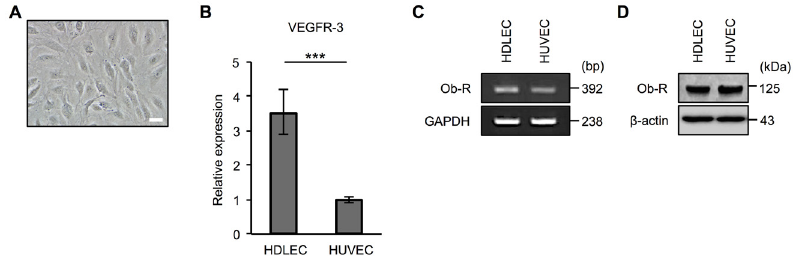
Fig 2. Characteristics of human lymphatic endothelial cells. ( A ) Phase contrast microscopy image showing the morphology of HDLECs used in this study. Scale bar: 1 μ m. ( B ) Real-time PCR to confirm the expression of VEGFR-3 mRNA in human HDLECs and HUVECs. Histograms represent the relative expression of VEGFR-3 mRNA. Results are expressed as means ± SEM of three independent experiments; *** p < 0.001, t -test. PCR ( C ) and immunoblot analysis ( D ) to confirm the expression of leptin receptor (Ob-R) mRNA ( C ) and protein ( D ) in HDLECs and HUVECs. ( B and C ) GAPDH was used as an internal control. bp: base pair. ( D ) β -actin was used as a loading